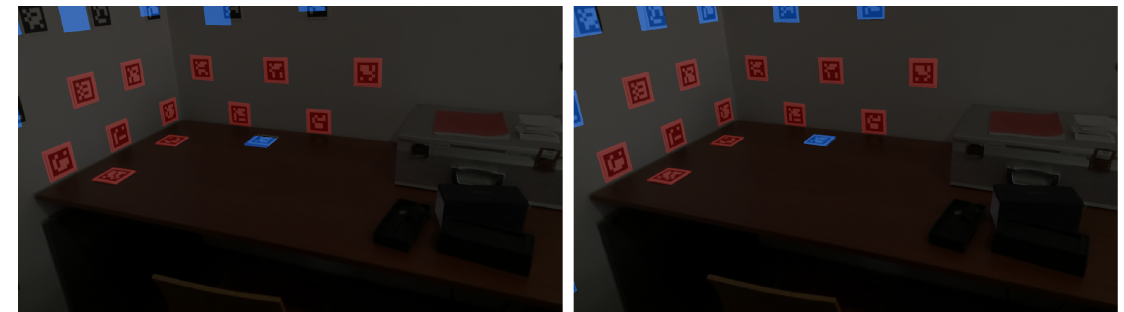
Figure 13. Masks obtained from aruco marker detection in red and masks obtained from projections from other cameras (cross-Inpainting) in blue: ( left ) before optimization; ( right ) after optimization.